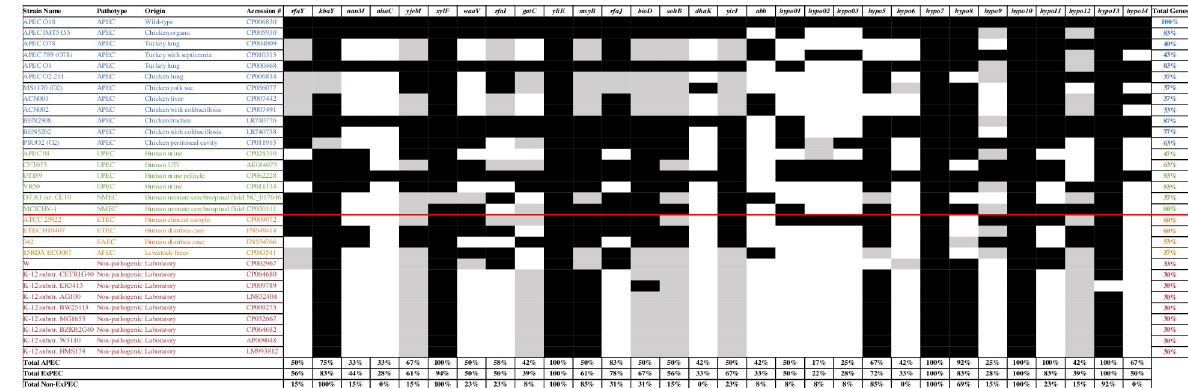
Fig 2. Results of in silico PCR on Geneious Prime. The prevalence of the thirty genes of interest in this study were evaluated in 31 strains of E . coli with in silico PCR using Geneious Prime. Strains evaluated were obtained from NCBI databases. Extraintestinal pathogenic E . coli (ExPEC) strains were compared to non-ExPEC strains, which are separated by the red line. ExPEC included 12 avian pathogenic E . coli (APEC, blue), four uropathogenic E . coli (UPEC, green), and two neonatal meningitis E . coli (NMEC, green). Non-ExPEC included two enterotoxigenic E . coli (ETEC, orange), one enteroaggregative E . coli (EAEC, orange), one livestock fecal E . coli (yellow), and nine laboratory strains of E . coli (red). Black boxes represent both forward and reverse primer sequences binding to the genome, gray represents only one sequence, and white represents no sequences. The “Total Genes” column is the percentage of genes present in the given strain, and the “Total” rows are the prevalence of each gene among the selected strains.